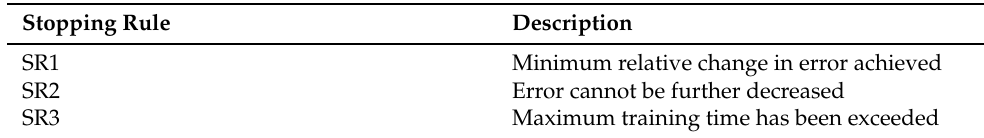
Table 2. List and description of the stopping